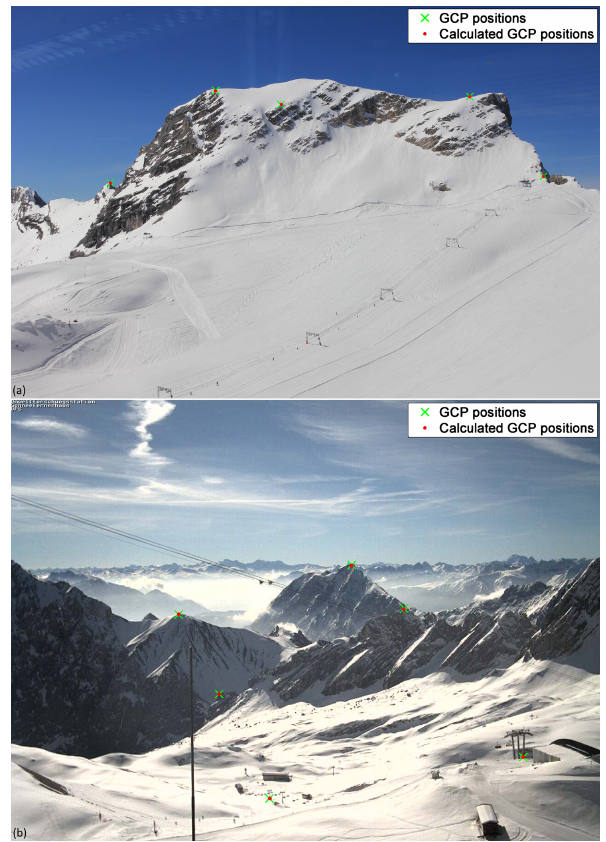
Figure 9. Real and calculated GCP positions for the investigated photographs on 7 April 2014: the root mean square error (RMSE) between real (green crosses) and calculated (red dots) GCP posi- tions are 0.5m for the SLR photograph (a) and 2.2m for the web- cam photograph (b) after the optimization of the camera